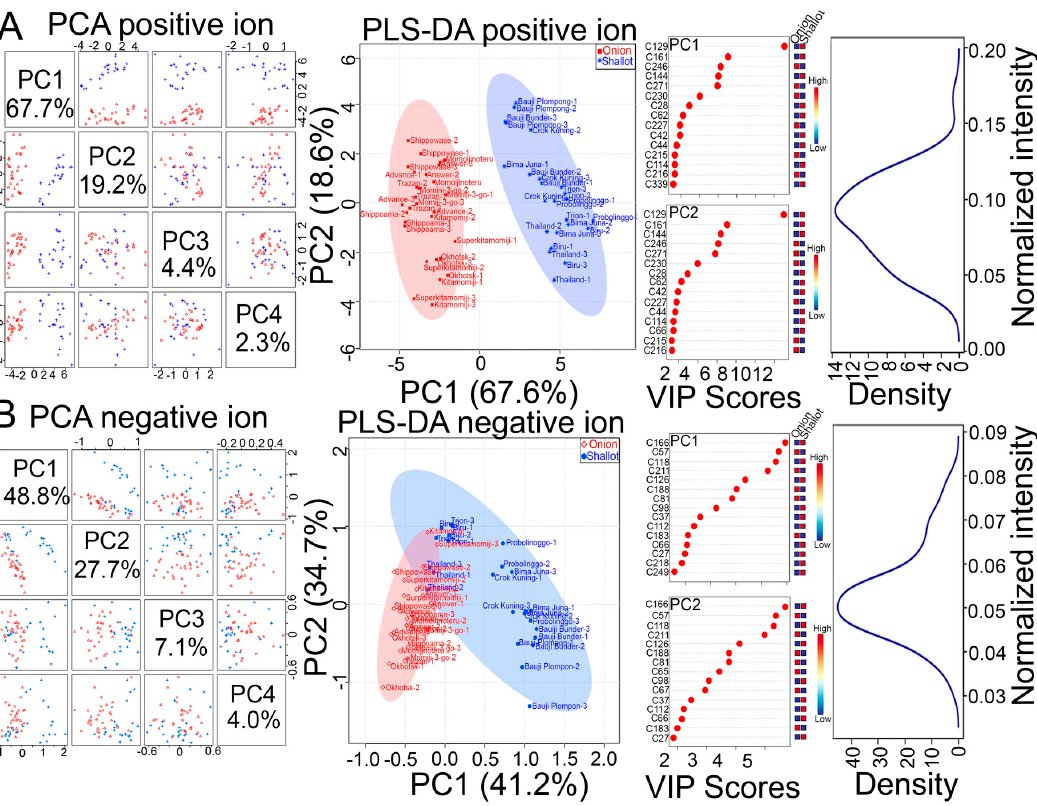
Figure 1. Principal component analysis (PCA) and partial least squares discriminant analysis (PLS-DA) of the assigned metabolite signal intensities obtained from the bulb samples of 10 Japanese short-day and long-day bulb onion cultivars and 8 Indonesian shallot landraces. ( A , B ) Score plots of variable importance in projection (VIP) and density distribution of metabolite signal intensities detected by using positive ( A ) and negative ( B ) ion modes of